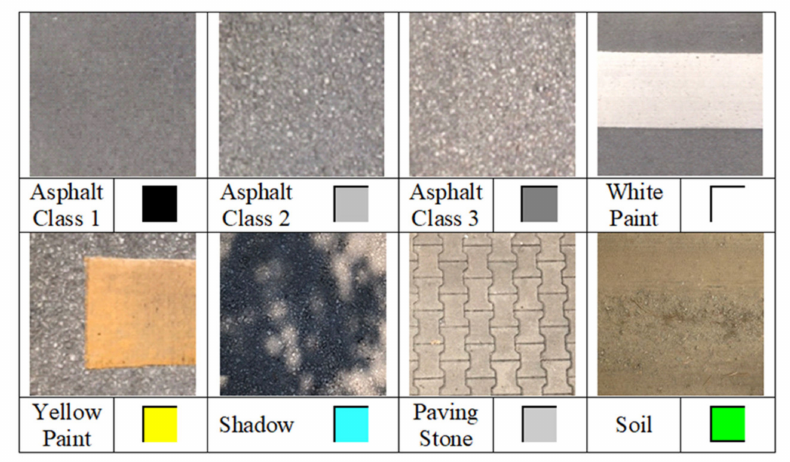
Figure 9. Sample images of the collected materials.